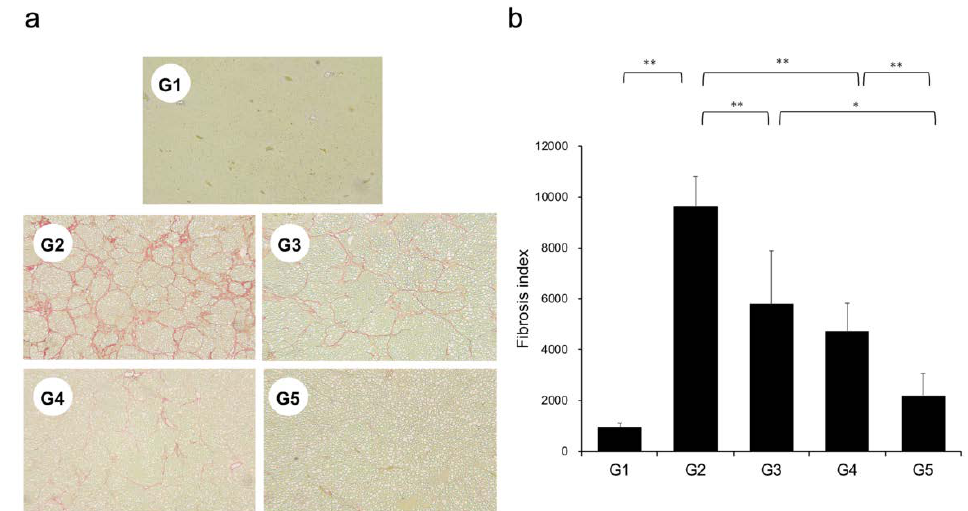
Figure 1. ( A ) Photomicrographs of liver sections stained with Sirius red. ( B ) Collagen content was calculated from Sirius red staining using image analysis software. G1, Group 1 (choline-sufficient, L-amino acid-defined diet); G2, Group 2 (choline-deficient, L-amino acid-defined diet (CDAA)); G3, Group 3 (CDAA+ canagliflozin (CA)); G4, Group 4 (CDAA+ teneligliptin (TE)); G5, Group 5 (CDAA+CA+TE); values represent mean ± SD ( n = 10). * p < 0.05, ** p < 0.01.